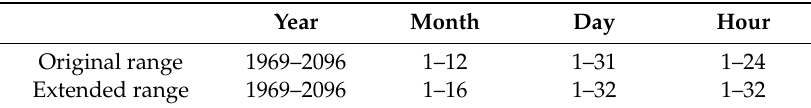
Table 1. Time division scheme.